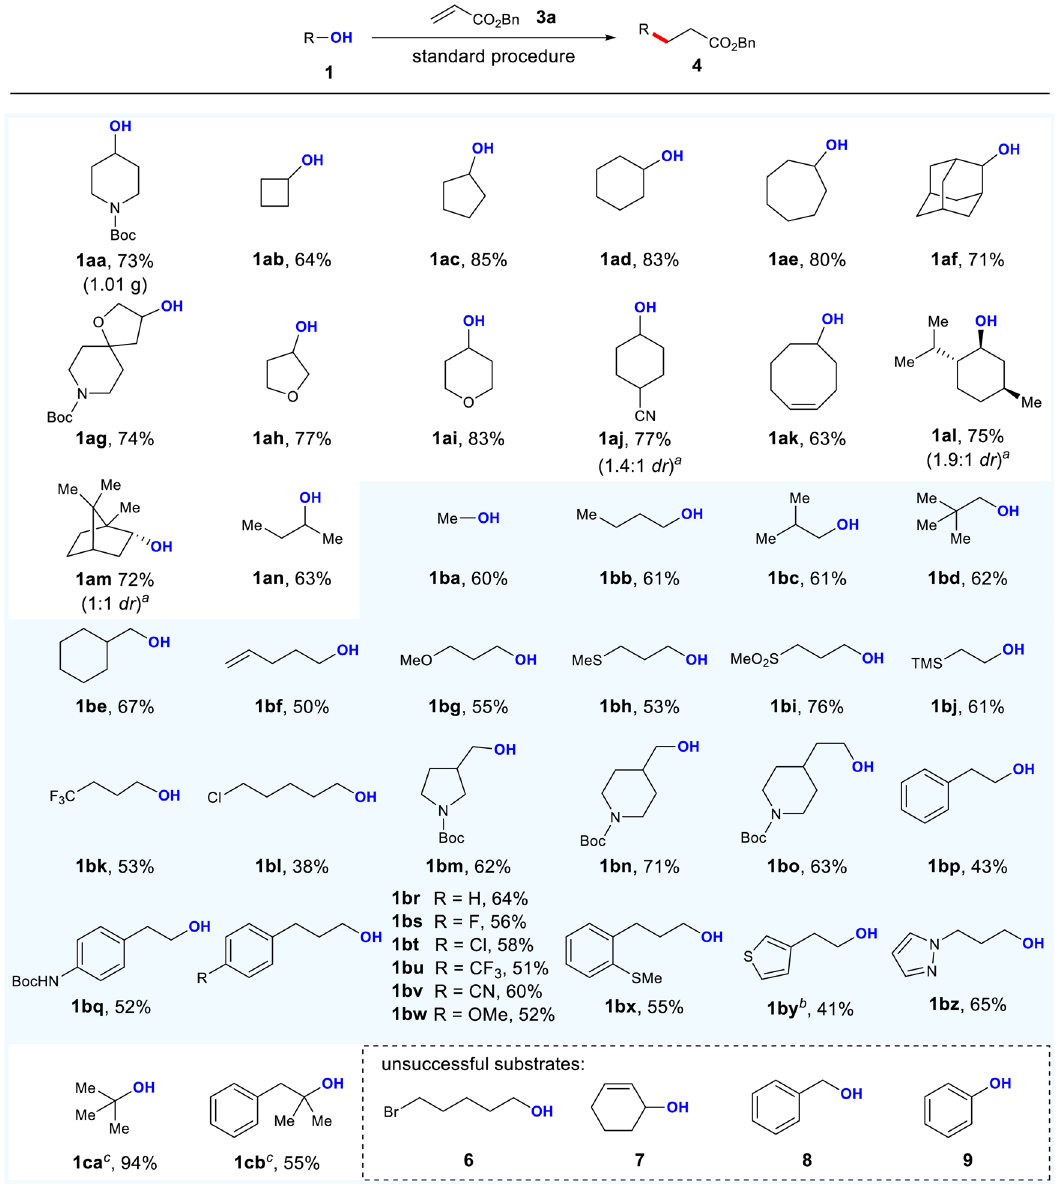
Fig. 2 Scope of alcohols. The standard procedure is as shown in Table 1. Isolated yields are reported. a The dr was determined by 1 H NMR analysis of